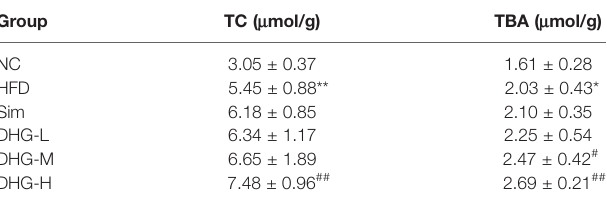
Values were mean ± SD, n = 10. TC, total cholesterol; TBA, total bile acids; NC, normal control group; HFD, high-fat diet group; Sim, simvastatin (2.40 mg/kg/day); DHG-L, DHG atlowdosage(0.37g/kg/day);DHG-M,DHGatmediumdosage(1.10g/kg/day);DHG-H, DHG at high dosage (3.3 g/kg/day). *p < 0.05, **p < 0.01 vs NC group; # p < 0.05, ## p < 0.01 vs HFD group.